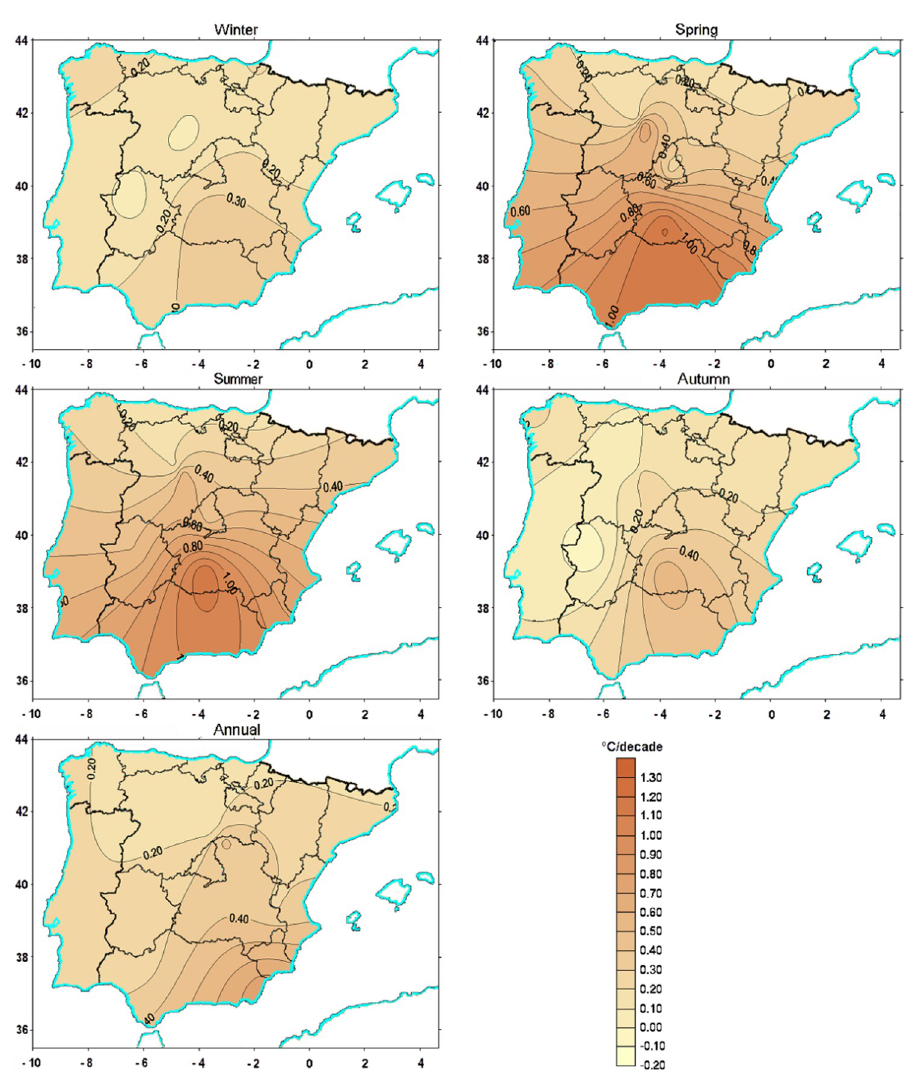
Figure 5. Isolines of seasonal and annual trends in mean temperature anomalies in Spain over the period 1950–2011, expressed in ºC decade -1